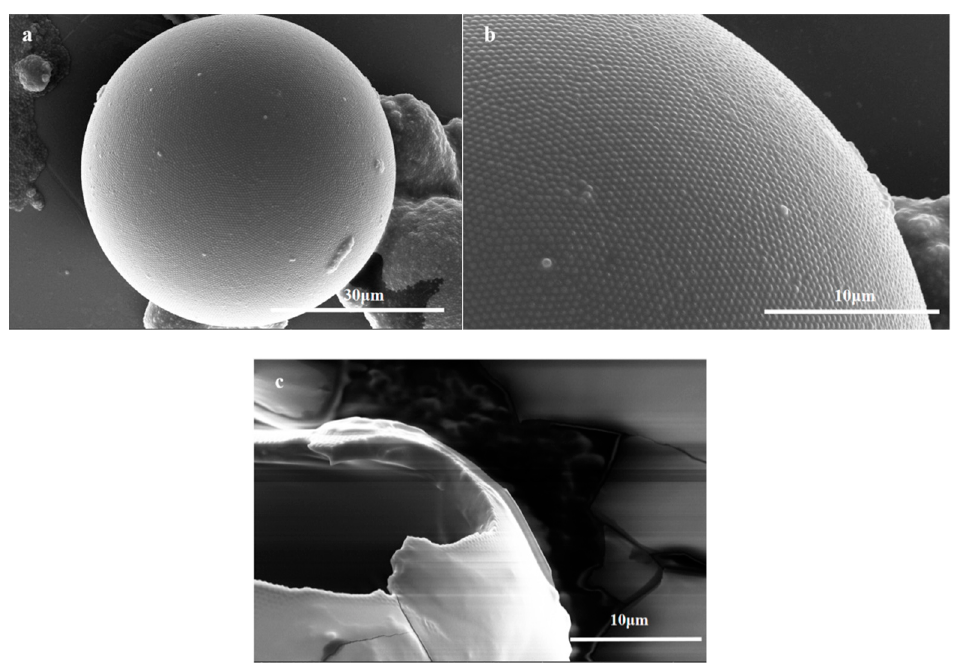
Figure 2. The SEM images of ( a ) TO-loaded microcapsules (core/shell ratio of 3:1), ( b ) the hydrolyzed PGMA particles coated on the microcapsules (core/shell ratio of 3:1), ( c ) a broken micocapsule (core/shell ratio of 3:1).